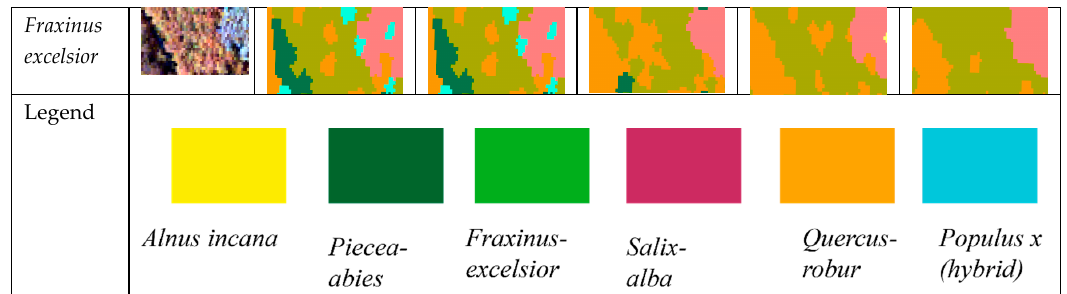
Figure 9. Detailed documentation of tree species classification using different dimensionality-reduced bands. The classification of the original bands from the APEX hyperspectral imagery is also included.